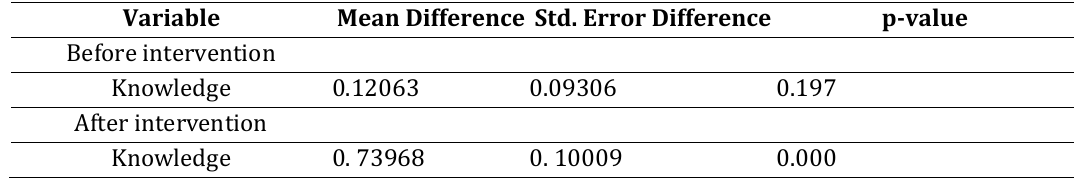
Parental Knowledge Before and After the Intervention Between Groups Variable Mean Difference Std. Error Difference